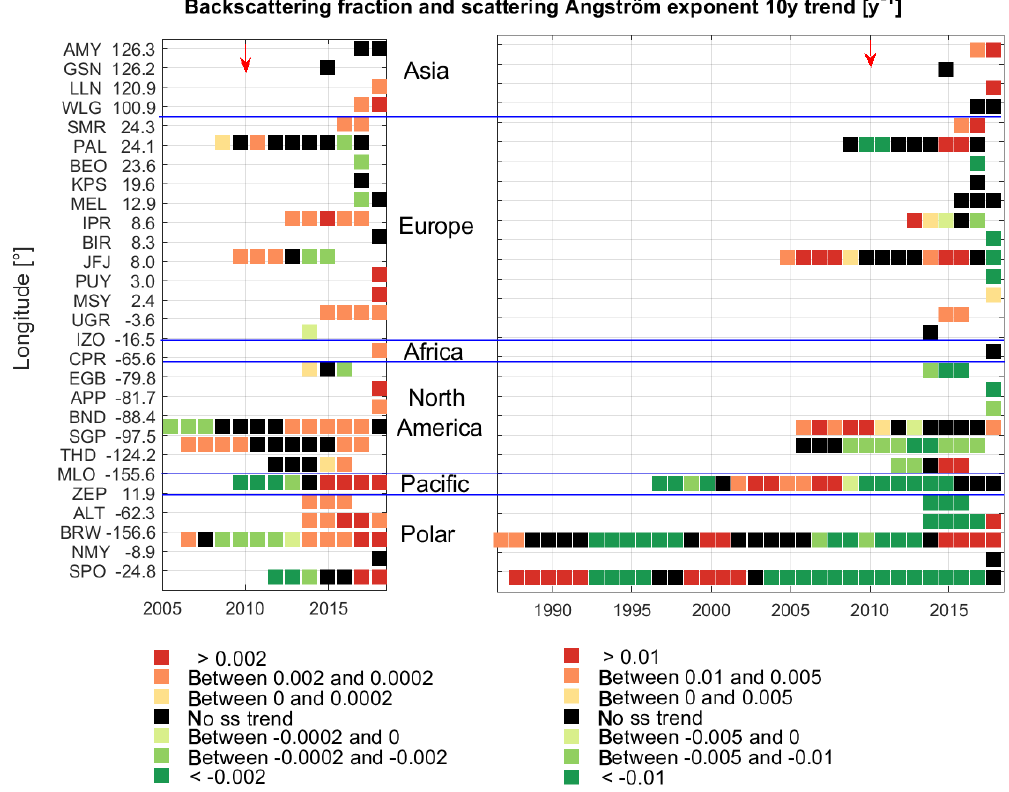
Figure 15. Time series of sequential 10-year b and å sp trends as a function of station longitude. The red arrows indicate the end of the time period covered in